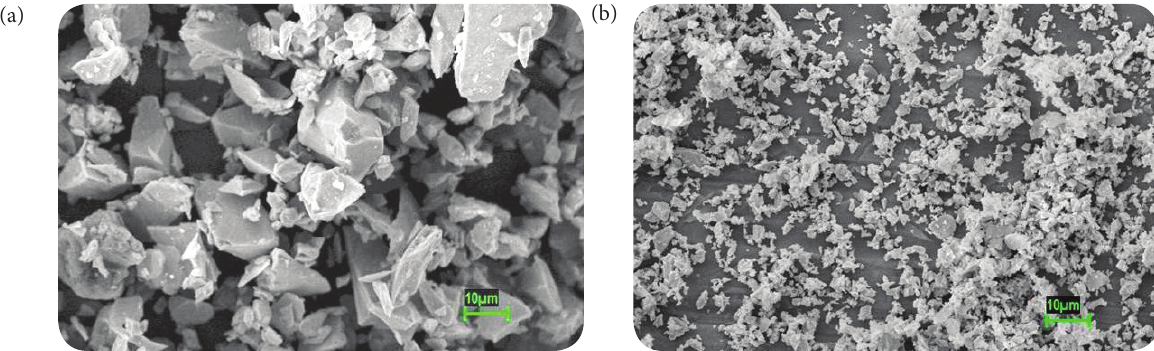
Figure 2. SEM micrograph of ZrB powder: (a) as-received and (b) after-planetary milling with 5:1 BPR. 2